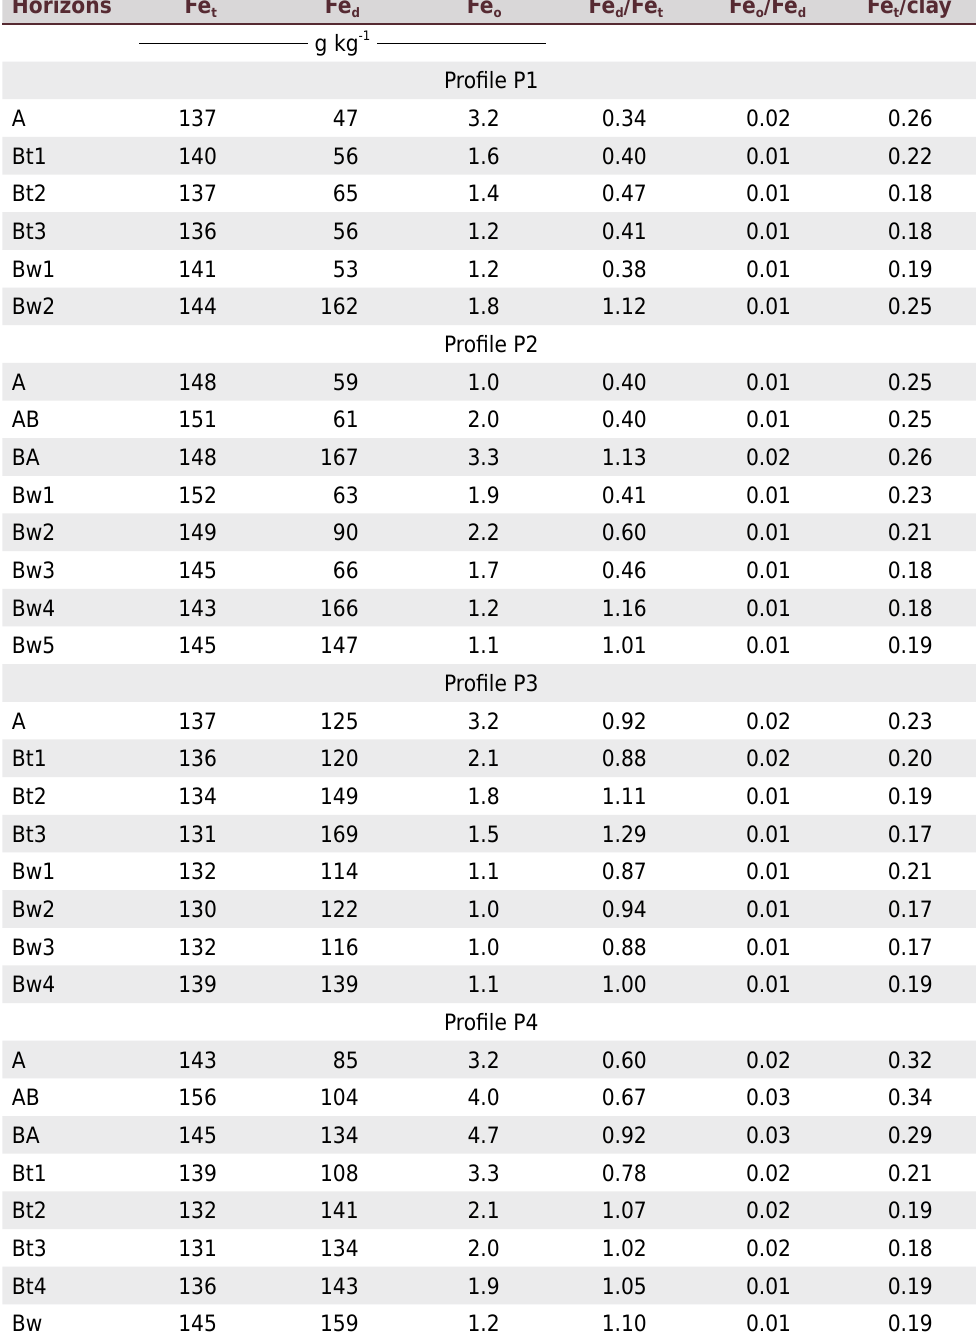
Table 4. Forms of iron extracted with dithionite–citrate–bicarbonate (Fe d ), acid oxalate (Fe o ) and total (Fe t ) (1) in the Rio de Janeiro State, Southeastern